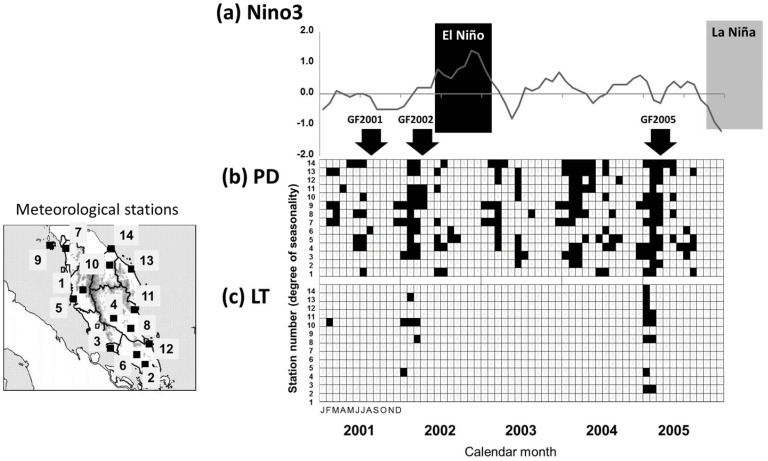
Occurrences of ENSO, PD and LT in Peninsular Malaysia from 2001 to 2005.(a) Niño 3 values as ENSO index, (b) months with PD (30-day moving total rainfall <40 mm) and (c) months with LT (daily minimum temperature <20°C). An El Niño episode occurred from summer 2002 to winter 2002–03, and La Niña from winter 2005 to spring 2006. Arrows indicate regional-scale GF episodes (GF2001, GF2002 and GF2005). Station names are identified in Table 2.